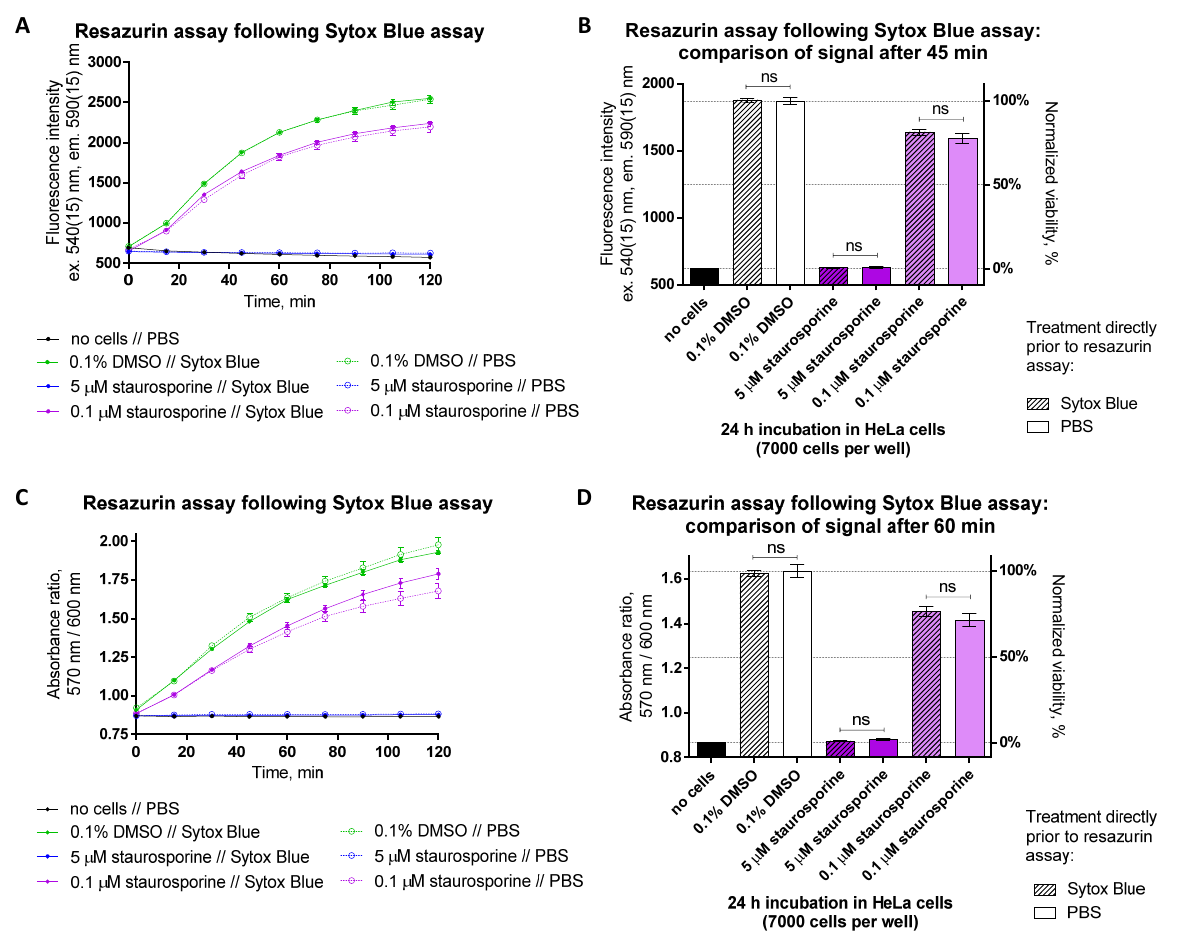
Figure 11. Resazurin assay can be combined with the SYTOX Blue assay assessing necrosis or late apoptosis in HeLa cells. Cells were treated with compounds (conditions indicated below graphs) for 24 h prior to measurement of necrosis or late apoptosis (data sets or columns marked as ‘SYTOX Blue’) and subsequent viability (at 48 h post-seeding). For assessing the impact of SYTOX Blue on the resazurin assay, some wells were treated with PBS only (not SYTOX solution in PBS) prior to the viability assay (data sets or columns marked as ‘PBS’). ( A , C ) Monitoring of change in fluorescence intensity (excitation at 540 nm) or absorbance ratio (570 nm/600 nm) during incubation of differently treated cells (conditions listed under the graphs) with 50 μ M resazurin. ( B , D ) Values of fluorescence intensity or absorbance ratio during incubation of cells with resazurin at the time corresponding to the end of linear range shown in graphs ( A , C ), respectively (45 min for fluorescence intensity readout and 60 min for absorbance ratio readout). In each graph, an average of 2 or more replicates ± SEM from three independent experiments is shown. In ( B , D ), the statistical significance of pairwise comparisons between the signals measured for identical treatments incubated with SYTOX Blue or PBS prior to the resazurin assay was established using unpaired two-tailed t -test (95% confidence level) with Welch’s correction: ns stands for not significant.